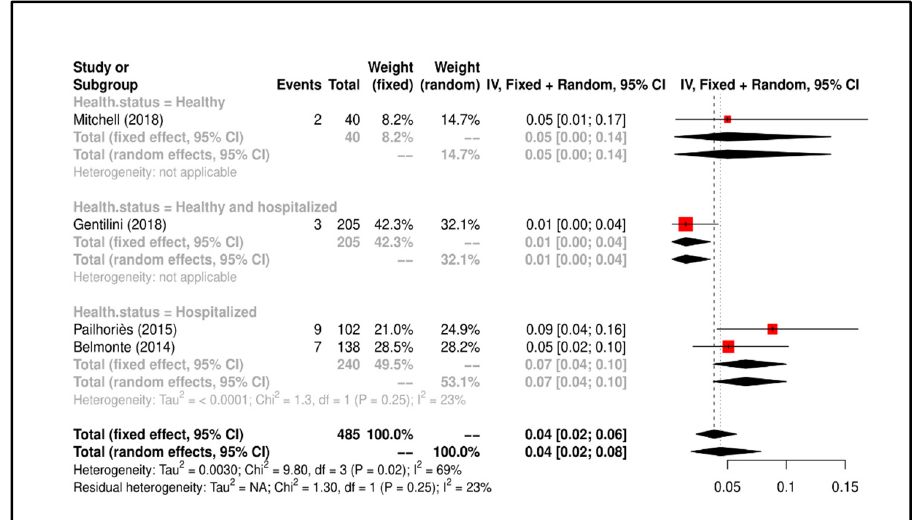
Figure 5. Forrest plot corresponding to occurrences of A. baumannii grouped by “health status of dog”.